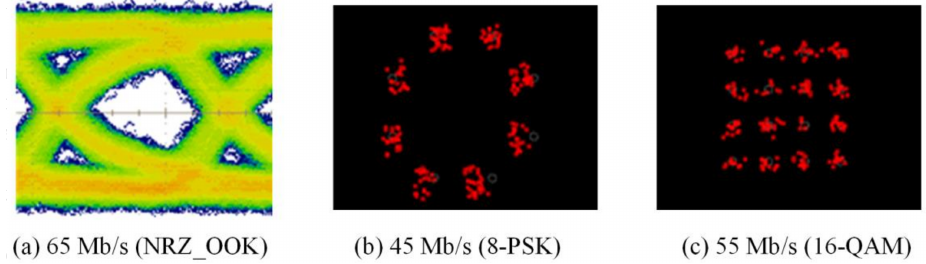
Figure 9. Micro-projection and data transmission of Blue LED with bandpass filter (BER = 10 − 3